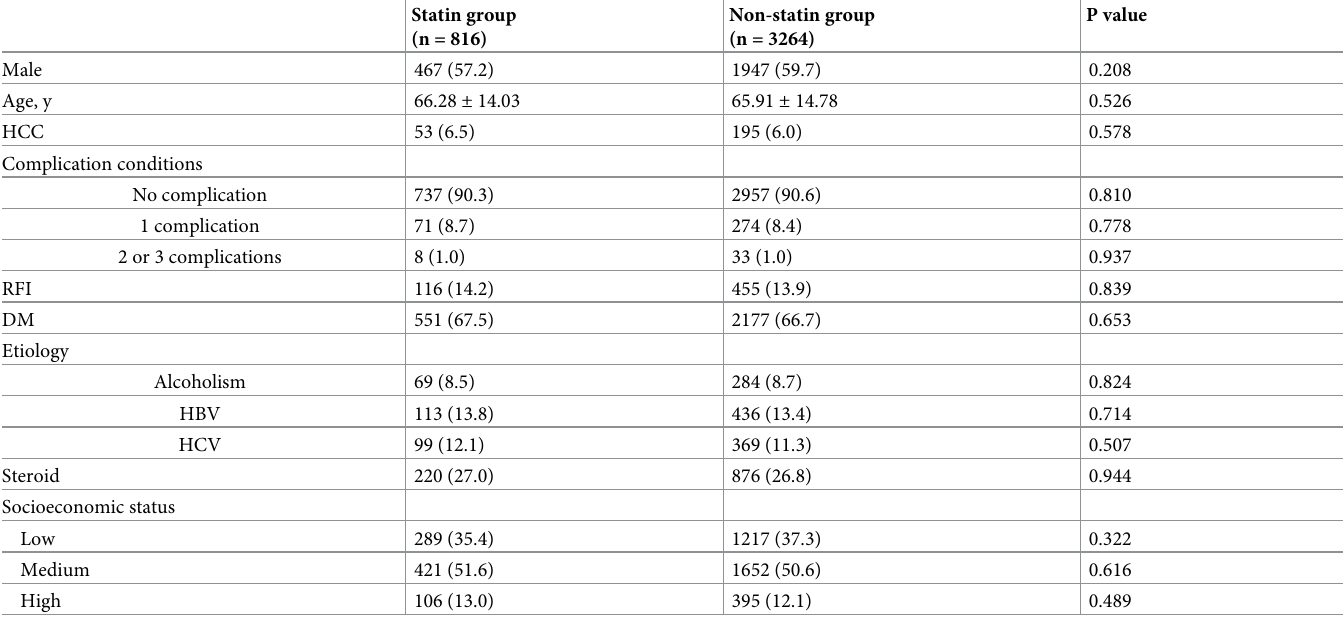
Table 1. Demographic characteristics of the statin and non-statin groups.